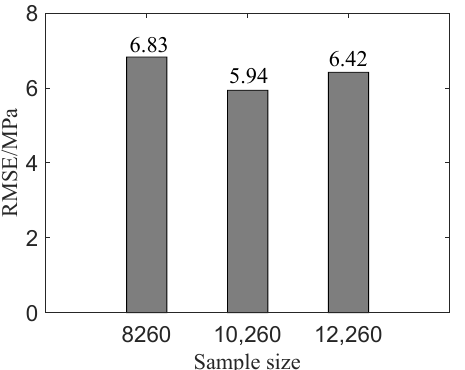
Figure 5. Influence of dataset size on prediction accuracy of U-Net.